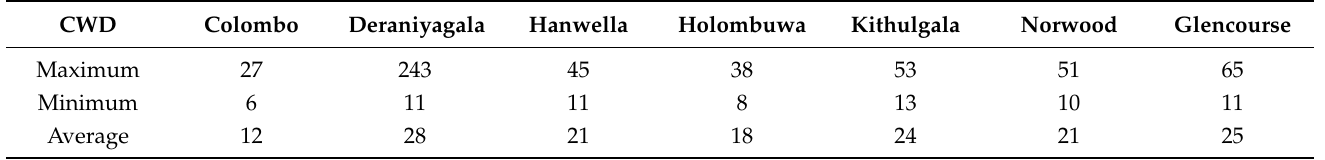
Table 6. CWD statistics from 1961 to 2019 for seven stations in the